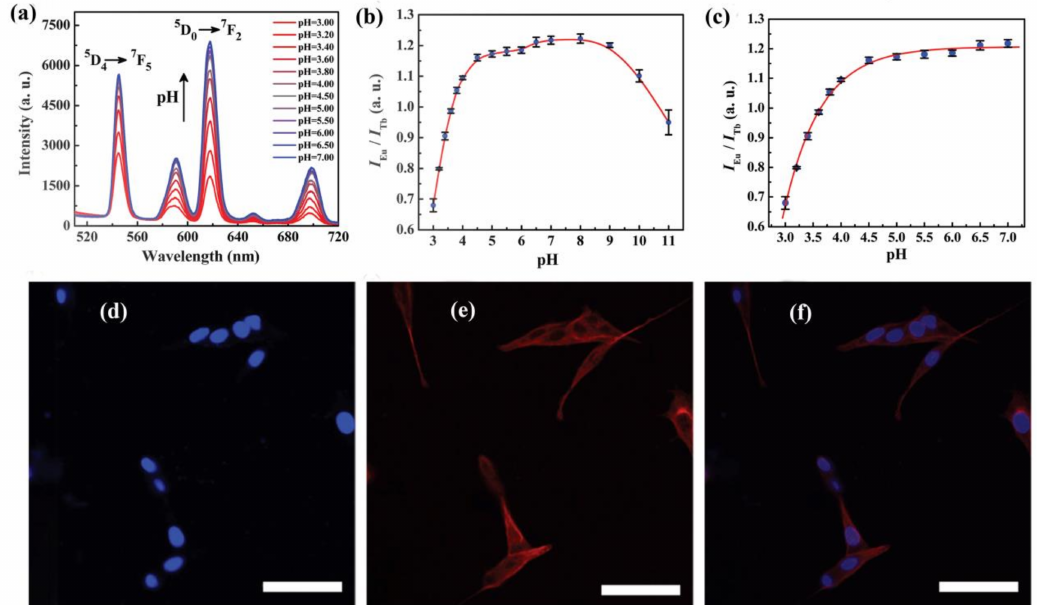
Figure 11. ( a ) pH-dependent emission spectra of Eu 0.034 Tb 0.966 -NMOF (W = 20, W is defined as the water-to-surfactant molar ratio) in the pH ranging from 3.00 to 7.00; ( b ) pH-dependent intensity ratio of Eu 3+ (618 nm) to Tb 3+ (545 nm) in the pH ranging from 3.00 to 11.00; ( c ) The fitted curve of Eu 0.034 Tb 0.966 -NMOF (W = 20) in the pH ranging from 3.00 to 7.00; ( d , e ) fluorescence and ( f ) overlapped confocal microscopy images of fixed PC12 cells incubated with 50 µ g · mL − 1 Eu 0.034 Tb 0.966 -NMOF